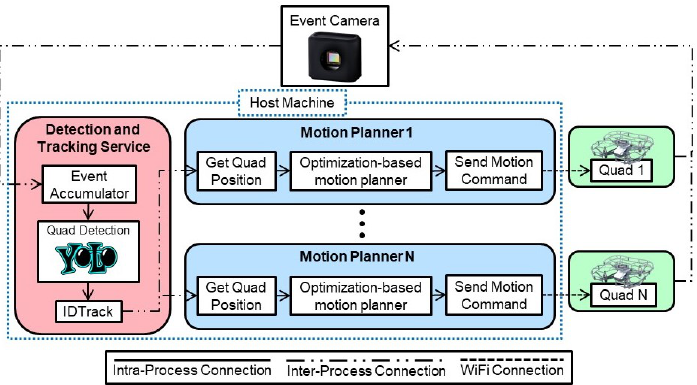
Figure 2. Modular multi-process system architecture developed as part of this study featured detection and tracking, and motion planning software services operated as processes on the host machine. The quadrotors received commands from their respective decentralized optimization-based motion planners over WiFi